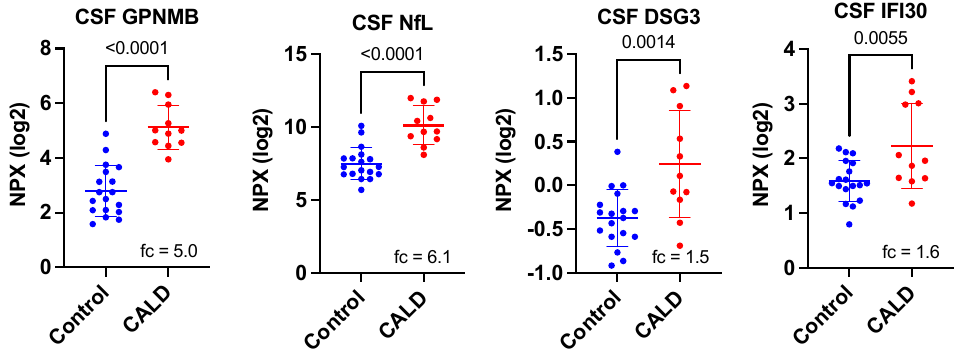
Figure 1. Significantly elevated CSF proteins between CALD and control patients identified on the Olink Neurology Exploratory Panel. Fc indicated fold-change after conversion to linear scale. p -values are derived from a Student’s t -test.